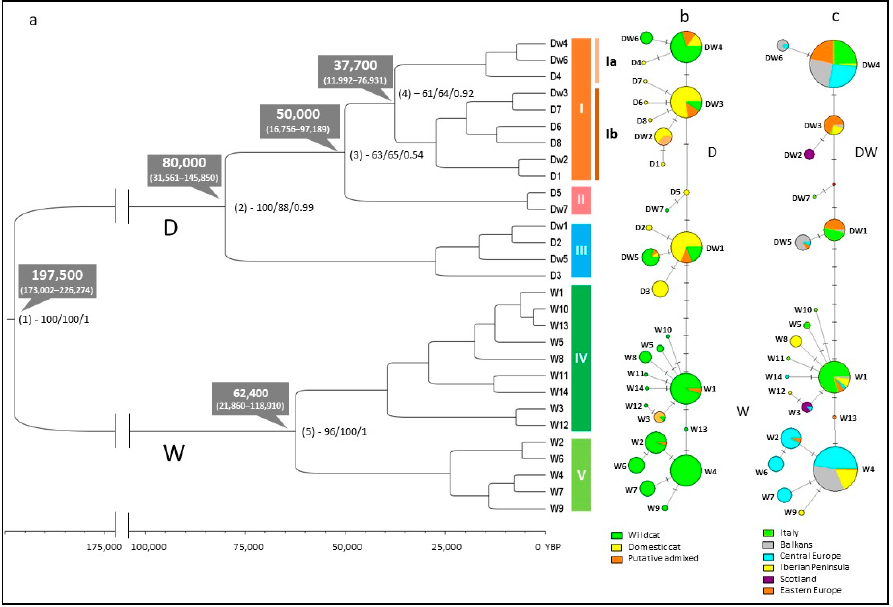
Figure 2. ( a ) Bayesian mtDNA tree (BT) computed in B EAST [57] showing the phylogenetic relation- ships among ND5 haplotypes obtained from all the 715 analyzed cat samples. Capitalized letters (D, W) indicate the two main lineages. Roman numerals (I–V) in coloured box indicate the main clades. Grey cartoons indicate the estimated node divergence times, whose 95% posterior density confidential intervals are reported in brackets. Annotated nodes show the Bayesian highest posterior density values and also the respective bootstrap values derived from the NJ and ML trees. ( b ) MJ networks among ND5 haplotypes were obtained from all 715 analyzed cat samples. Haplotypes, according to the 31-STR Bayesian assignment values of their belonging samples [25], were parti- tioned and colored as domestic, wild, and putative admixed groups. ( c ) MJ networks among ND5 haplotypes, including only wildcats and putative admixed individuals (n = 502). Each haplotype was divided and colored according to the proportion of individuals belonging to each biogeo- graphic macro-region. Small bars indicate the number of mutations (greater than one) between two different haplotypes. The frequency of each haplotype is proportional to the size of the circles.